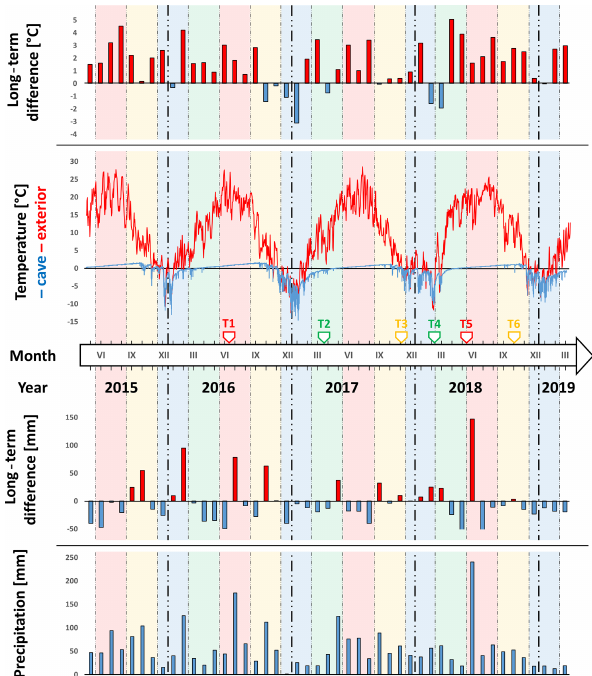
Figure 9. Long-term daily and monthly mean temperature (above the timeline) and precipitation (below the timeline) and their de- viations from the long-term average. The timeline shows the dates on which TLS mapping was performed. The background colours of the graph show the season (red – summer, yellow – autumn, blue – winter, green – spring). The bold dashed lines separate the years. Source: data supplied by SHMÚ (2019) and our own